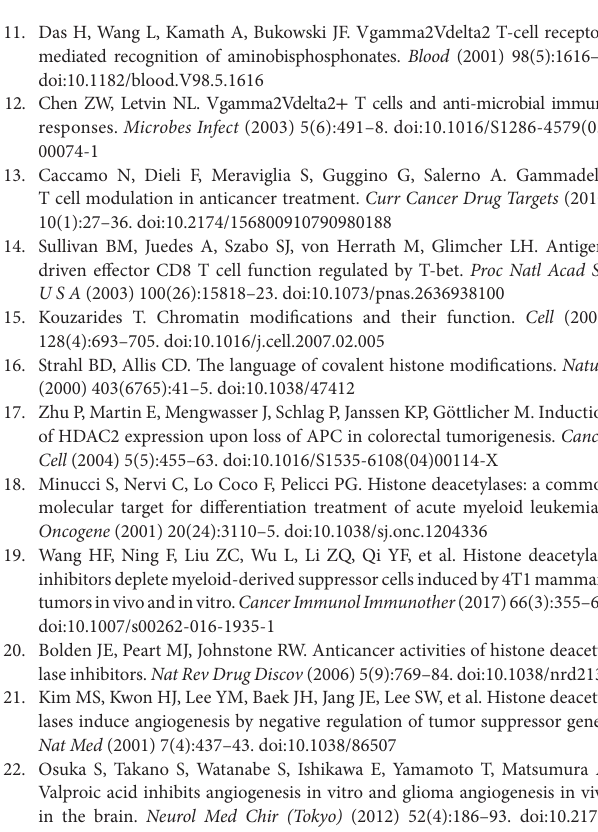
FigUre s4 | Histone deacetylases (HDAC) inhibitors differentially affects the expression of activating and inhibitory receptors in γδ T cells. The expression of (a) NKG2D, (B) KIR2D2L2/3, and (c) CD16 by γδ T cells in the presence and absence of HDAC inhibitors after 72 h was analyzed by flow cytometry. The histograms are representative of three individual experiments. The values on right side of histograms indicate median fluorescence intensity. HDAC inhibitors reduce NF κ B expression in γδ T cells. Protein expression of NF κ B by γδ T cells upon treatment with (c) sodium valproate, (D) Trichostatin-A, and (e) suberoylanilidehydroxamic acid as detected by western blotting. Cell lysates of γδ T cells, stimulated with HDMAPP after treatment with HDAC inhibitors at different concentrations for 72 h were probed with NF κ B antibody, β -actin was used as loading control. The blots shown are representative of three experiments. FigUre s5 | Histone deacetylases (HDAC) inhibitors decrease the acetylation on promoters of perforin and granzyme B in γδ T cells. (a) γδ T cells treated with HDAC inhibitors sodium valproate (VPA), Trichostatin-A (TSA), and suberoylanilidehy droxamic acid (SAHA) show increased acetylation of H3 and H4. Expression of acetyl Histone 3 and acetyl histone 4 in γδ T cells was detected by western blotting and total H3 and total H4 were used as loading control. The blots shown are representative of three experiments. Chromatin immunopre cipitation qPCR was used to analyze the histone H3 acetylation (B) and histone H4 acetylation (c) on perforin region I ( − 103 to + 27 bp), perforin region II ( − 309 to − 130 bp); granzyme B region I ( − 130 to + 11 bp), and granzyme B region II ( − 263 to − 77 bp) from the transcription start site (TSS) of perforin and granzyme B in γδ T cells treated with or without HDAC inhibitors VPA (2 mM), TSA (100 nM), and SAHA (1 µM) for 72 h. Enrichment of promoter regions of Perforin and Granzyme B was quantified by qPCR and expressed as percentage of input DNA. The images above the graphs are schematic representation of Perforin and granzyme B promoter regions including the TSS. All results indicated are mean + SEM where * p < 0.05, ** p < 0.005, *** p <